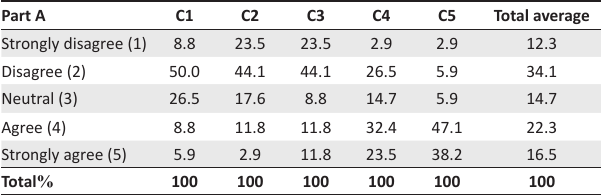
TABLE 3 : Provincial MuniMEC functionality.